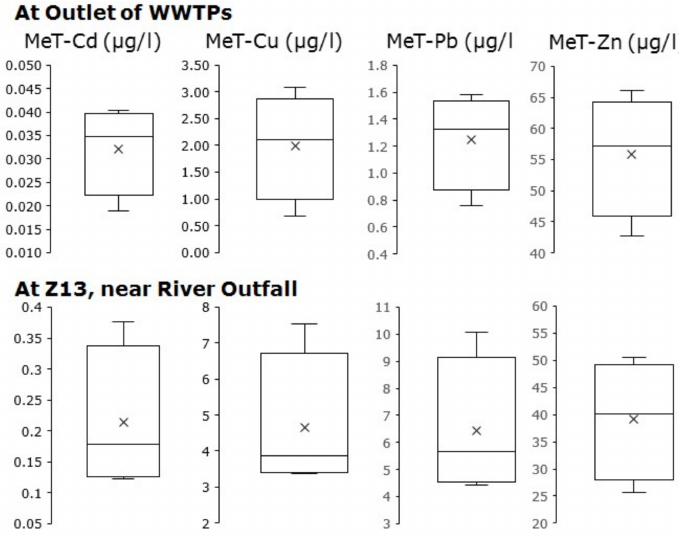
Figure 3. Box plots of the total metal concentrations at the outlet of waste water treatment plants (WWTPs) (top row) and at Good Ecological Status of the river Zenne (GESZ) station Z13, near the river outlet (bottom row), measured during the GESZ sampling